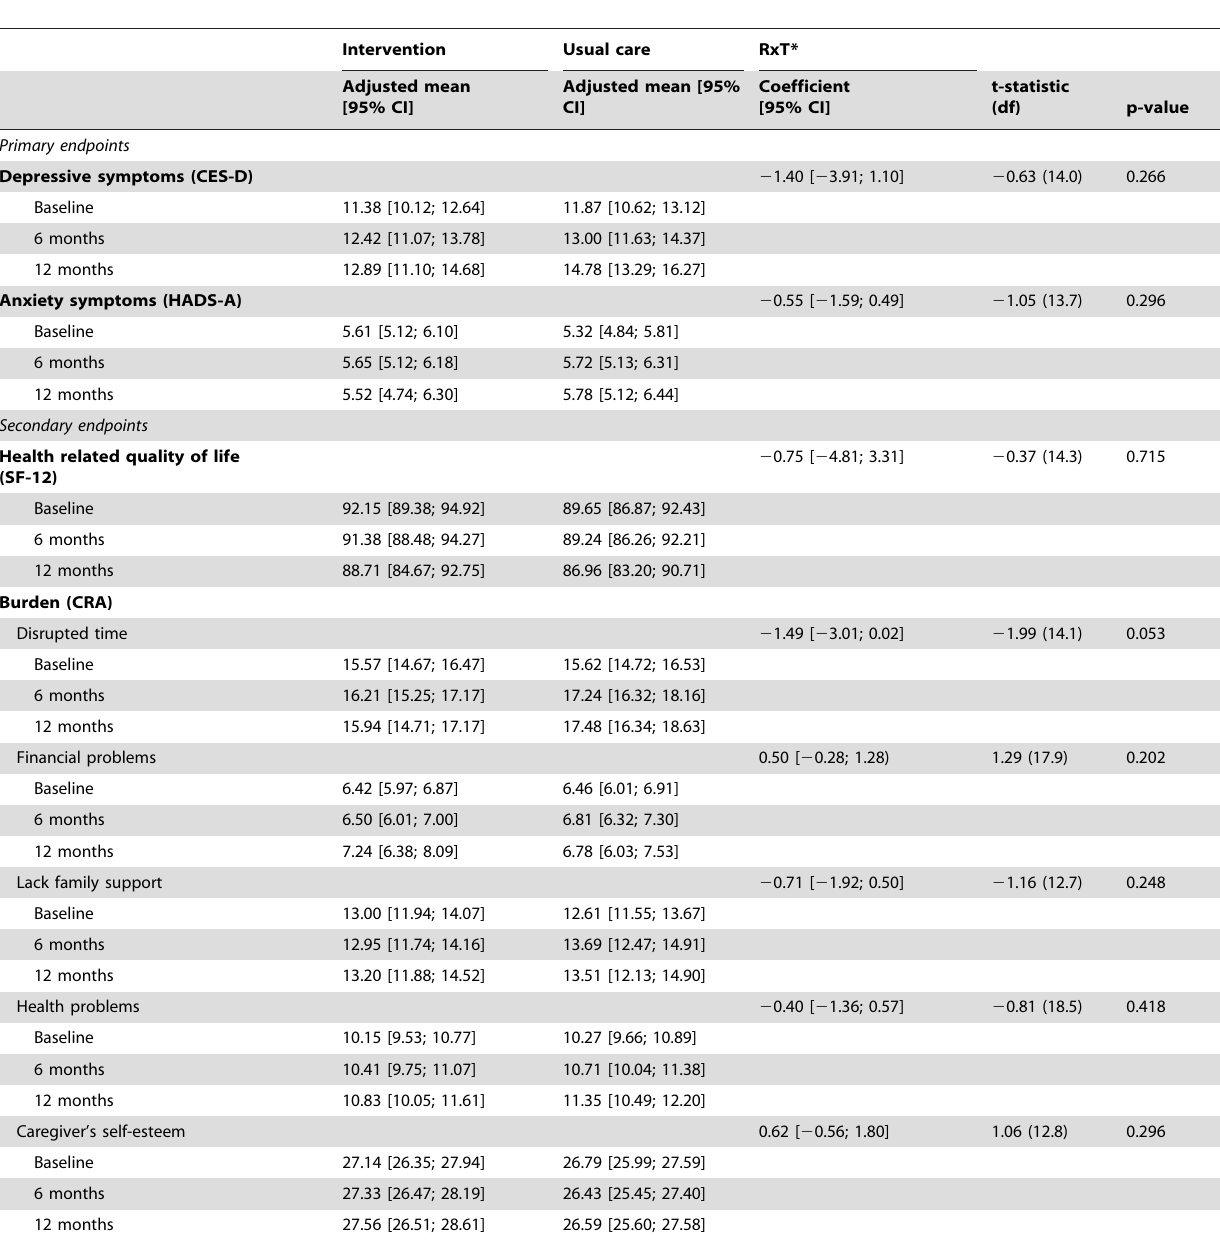
Table 3. Longitudinal changes on continuous outcome measures: depressive symptoms, anxiety symptoms, caregiver burden and health related quality of